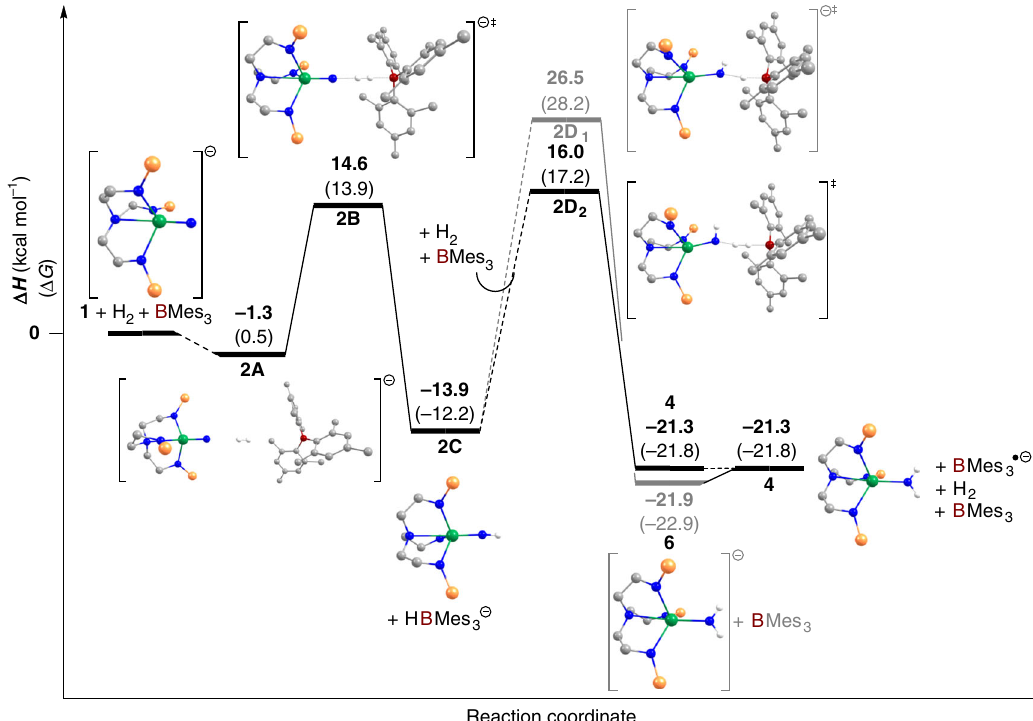
Fig. 10 Computed reaction pro fi le for the conversion of 1 to 6 and then 4 in the presence of BMes 3 . The iso -propyl groups of the silyl substituents, carbon-bound hydrogen atoms, and [K(B15C5 2 )] + cation accommodated in the calculations are omitted for clarity. Bold numbers without parentheses refer to Δ H values and numbers in parentheses are Δ G values, both quoted in kcal mol − 1